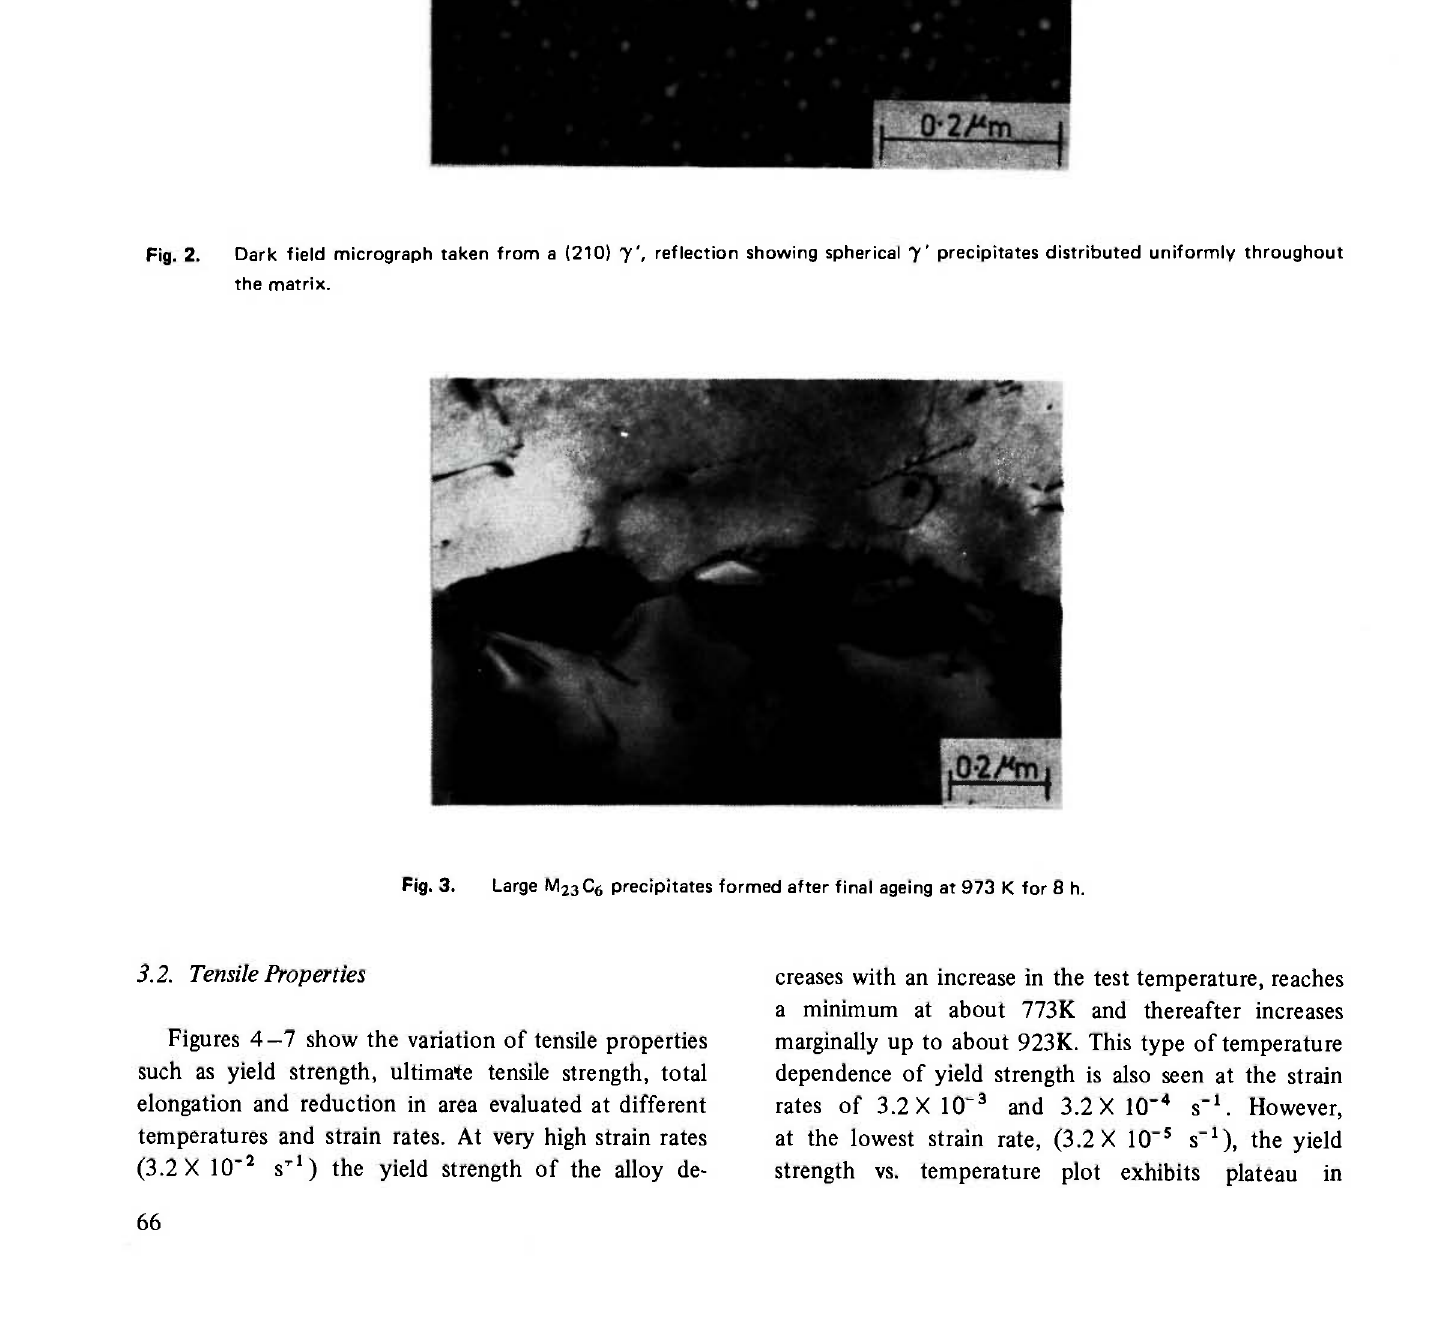
Dark field micrograph taken from a (210) γ', reflection showing spherical 7' precipitates distributed uniformly throughout the